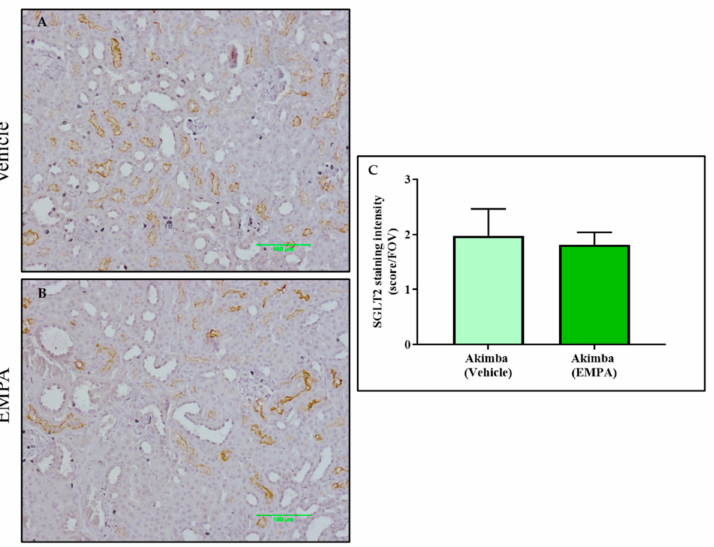
Figure 7. EMPA was not associated with increased SGLT2 protein expression in the kidneys of diabetic Akimba mice. Representative images of SGLT2-stained kidney tissues from diabetic Akimba mice treated with Vehicle ( A ) and diabetic Akimba mice treated with EMPA ( B ) and SGLT2 quantification ( C ). Scale bar = 100 µ m; n = 3 mice/group; EMPA: